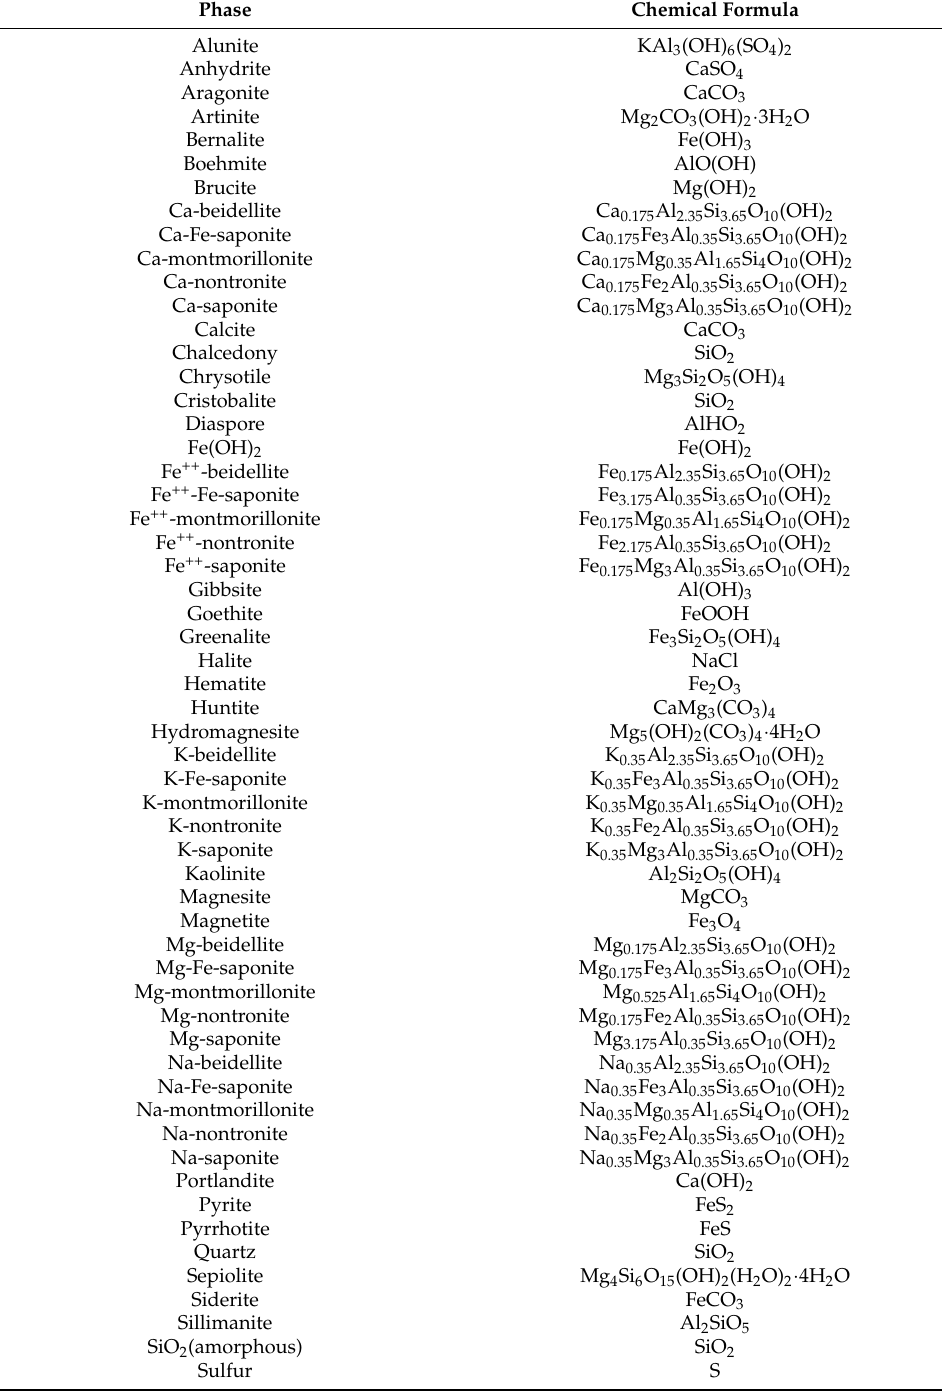
Table A1. Phases considered in the water–rock reaction